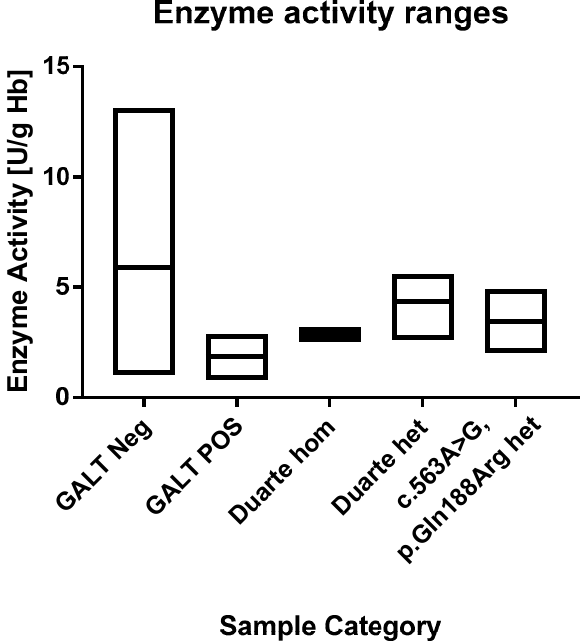
Figure 4. Ranges of the GALT enzyme activities. Each box describes the full range of the sample categories. The median values are depicted with a line within the boxes.